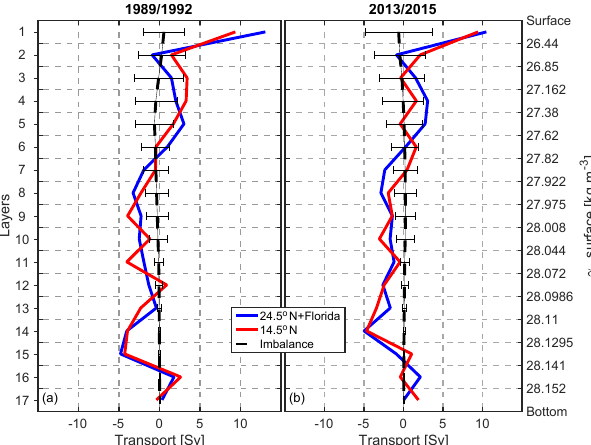
Figure 11. Meridional overturning stream function from the inverse model at (a) 14.5 ◦ N and (b) 24.5 ◦ N. It is calculated by cumula- tively integrating the layer transport from the surface to the bottom. The vertical coordinate in (a) is the layer number and in (b) the cor- responding neutral density surfaces. For the 14.5 ◦ N section, the red solid curve stands for the 1989 realization and the red dashed curve for the 2013 realization. For the 24.5 ◦ N section, the blue solid curve stands for the 1992 realization and the blue dashed curve for the 2015